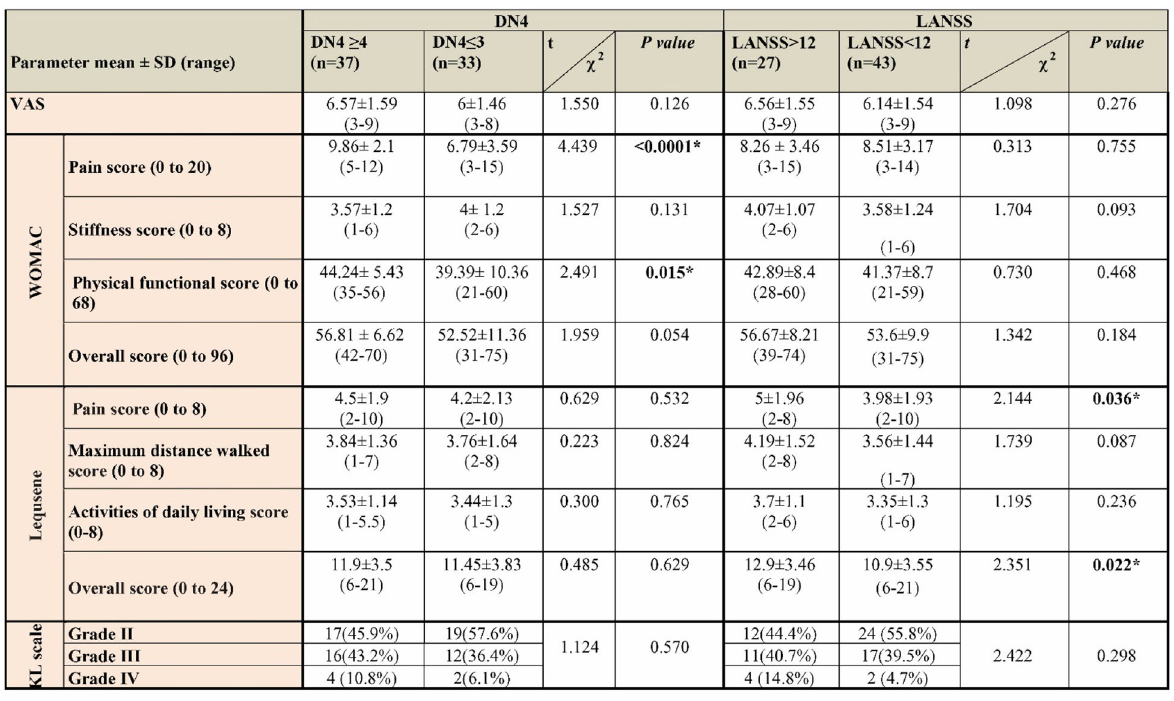
Table 4 Comparison of WOMAC scores, lequesene scores and Kellegren Lawrance scale between patients with neuropathic pain and those with non-neuropathic